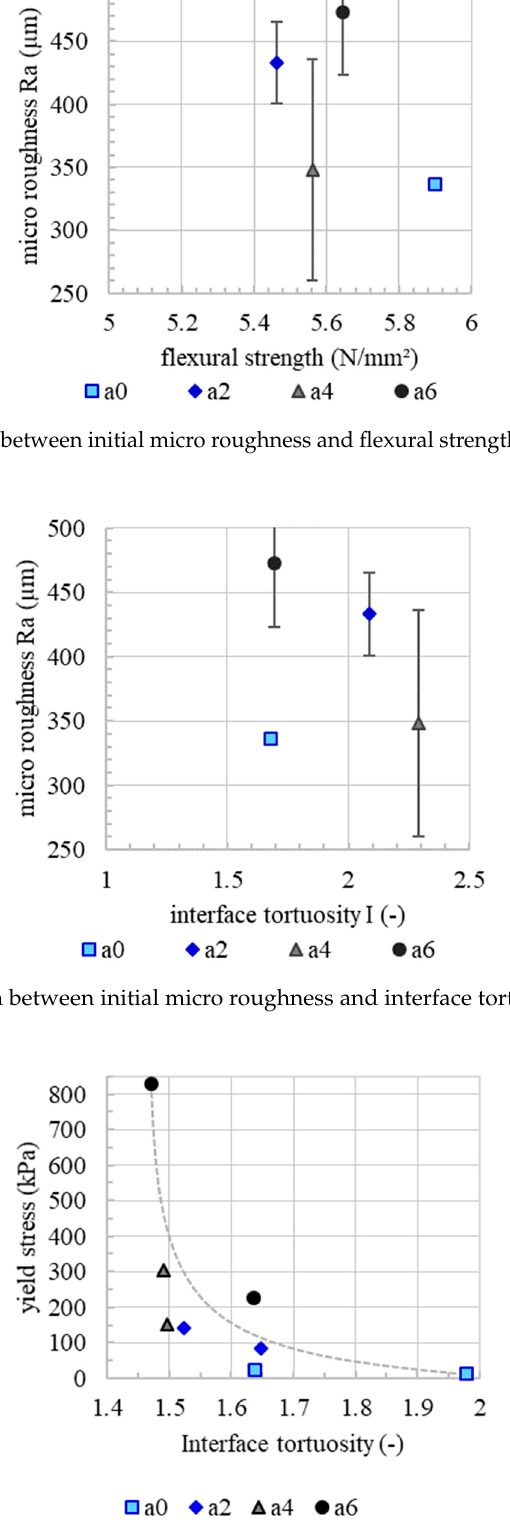
Figure 10. Micro roughness of the surface layer of specimen containing 0% (a0), 2% (a2), 4% (a4) and 6% (a6) of accelerator.